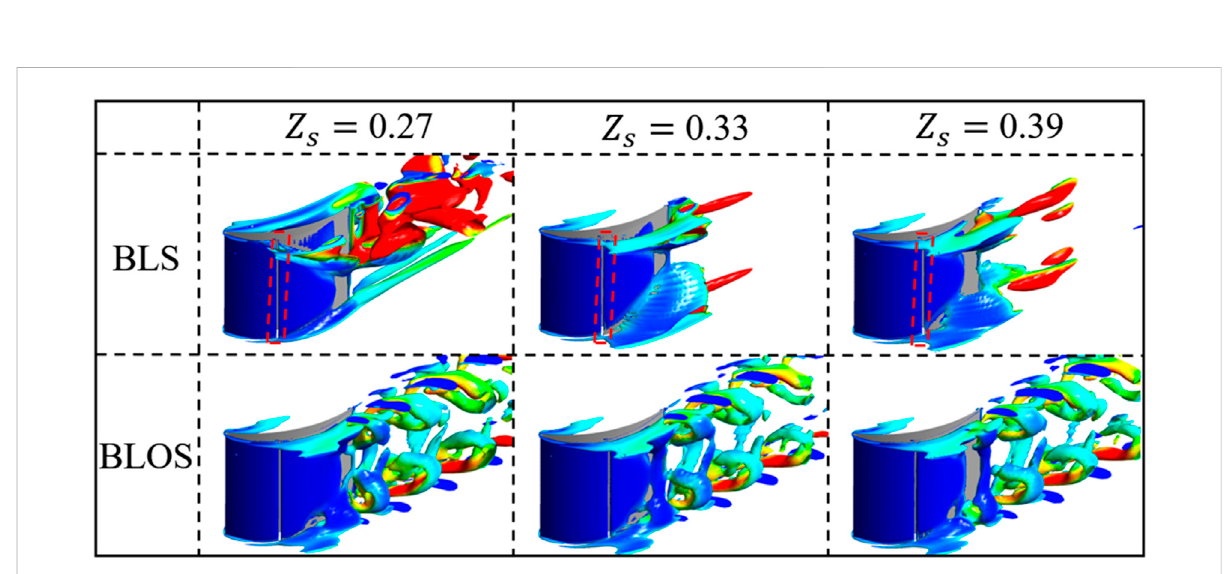
FIGURE 12 Instantaneous vortex structures by different suction locations in the control of BLOS and